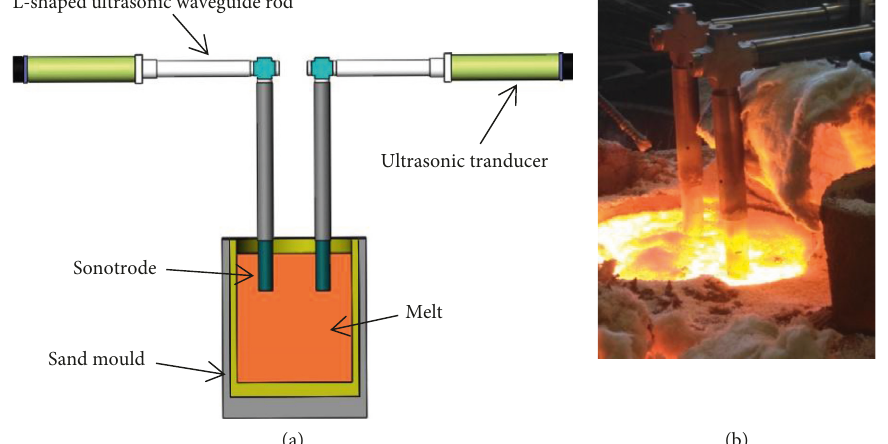
Figure 2: The ultrasonic equipment.